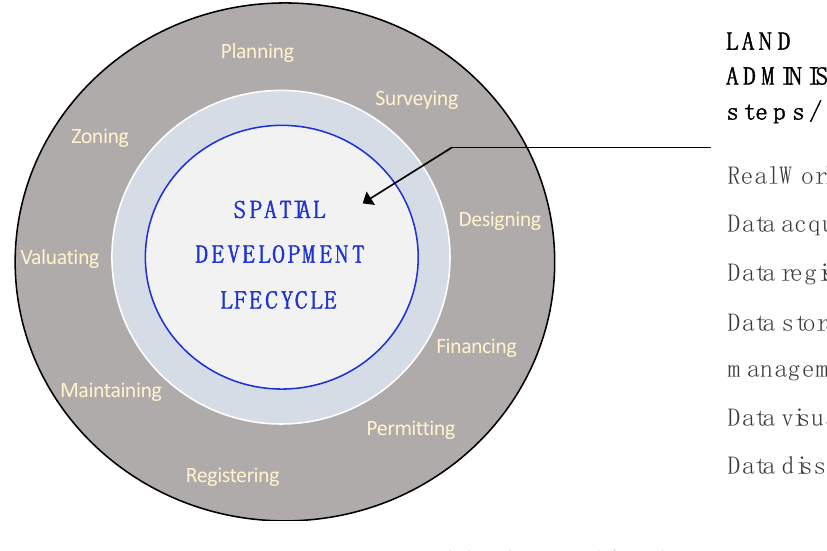
Figure 1. Spatial development lifecycle.